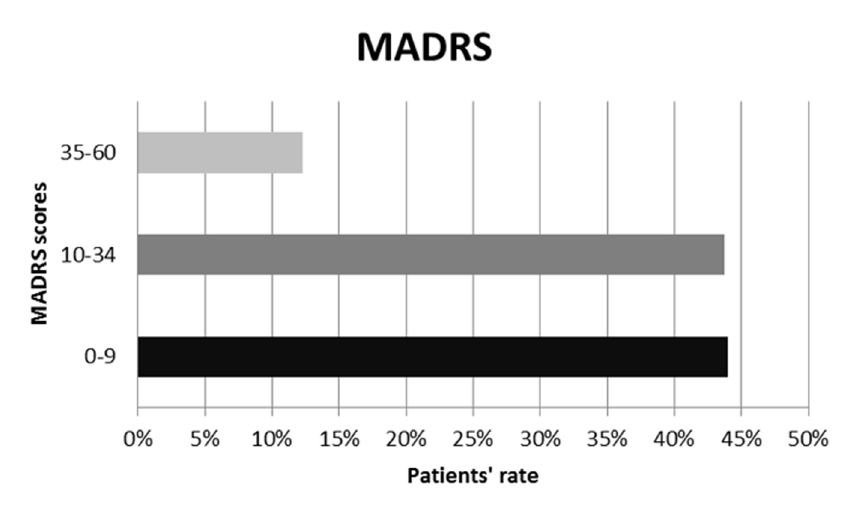
Figure 1. MADRS global scores.